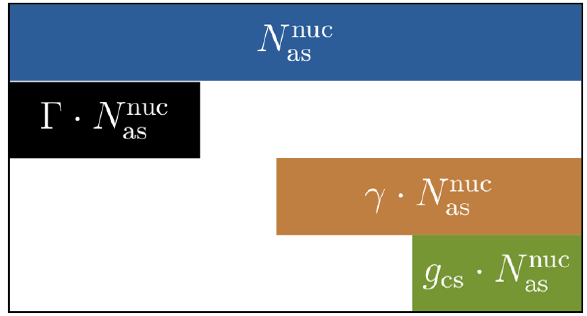
Figure B1. Illustration of the transfer concept for mode “as” cloud particle cores upon impaction scavenging of particles that in- duce such transfers. The blue bar represents the number concen- tration of mode “as” aerosol particles that have nucleated cloud particles; the boxes below it represent the number concentrations of impaction-scavenged aerosol particles from the three consid- ered classes: coarse-mode particles that contain insoluble material (black), fine-mode particles that contain insoluble material (brown), and soluble coarse-mode particles (green). See text for explanation of the